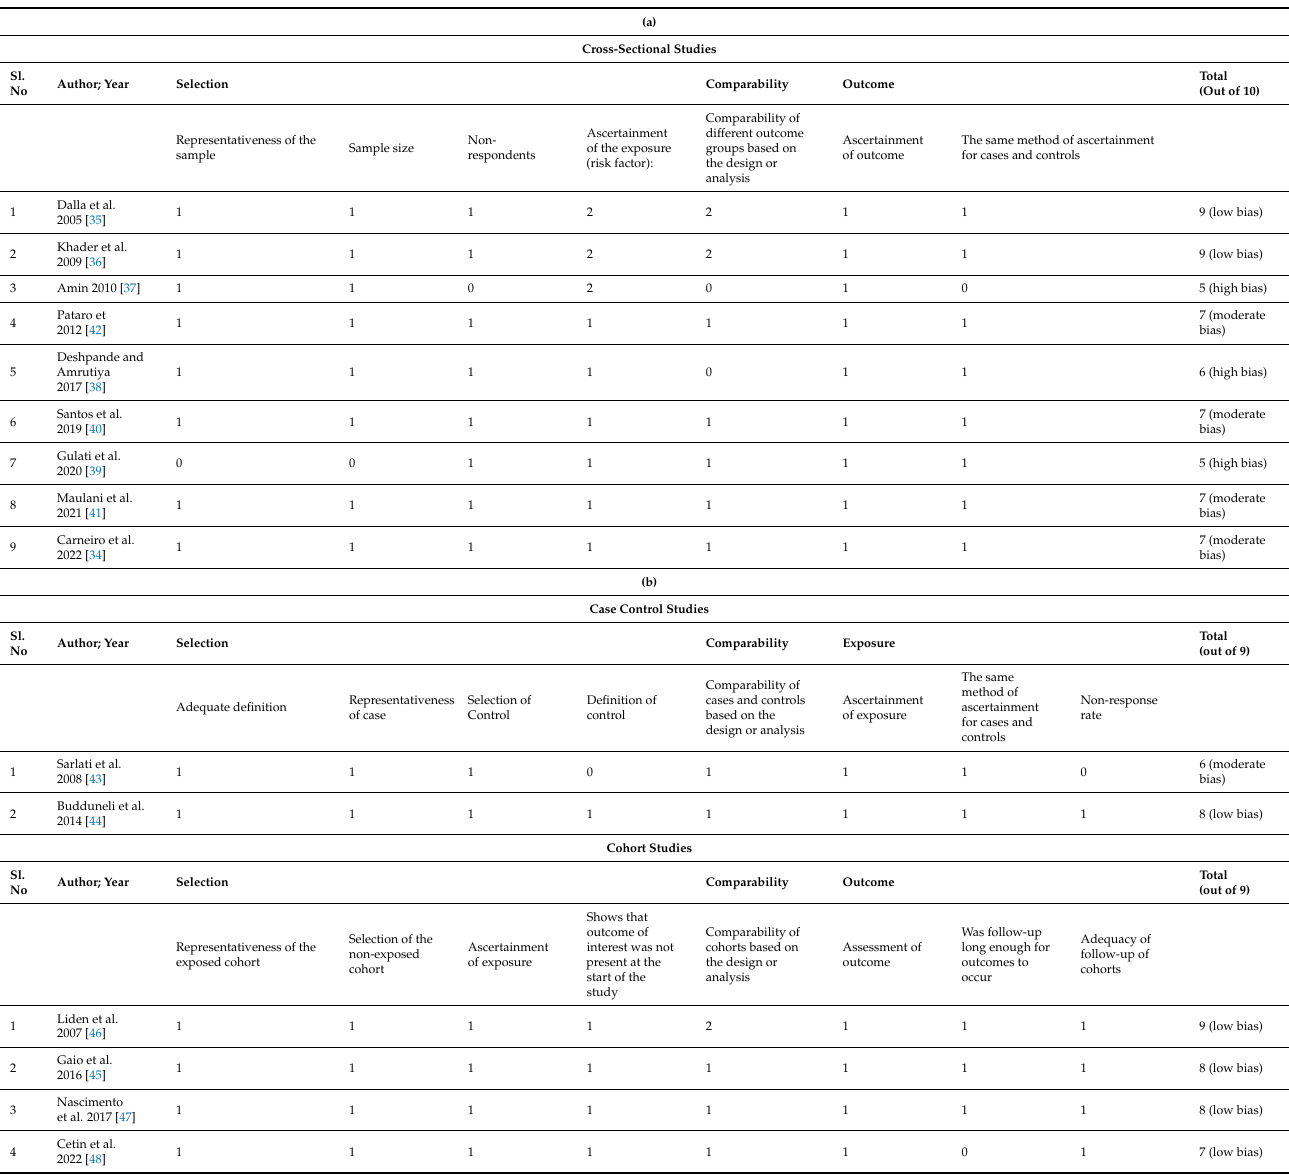
Table 4. ( a ): Risk of bias in individual cross-sectional studies using The Newcastle–Ottawa Quality Assessment Scale by Dubey et al. 2022 [31]. ( b ): Risk of bias in individual case-control and cohort studies using the Newcastle–Ottawa Quality Assessment Scale by Stang et al. 2010